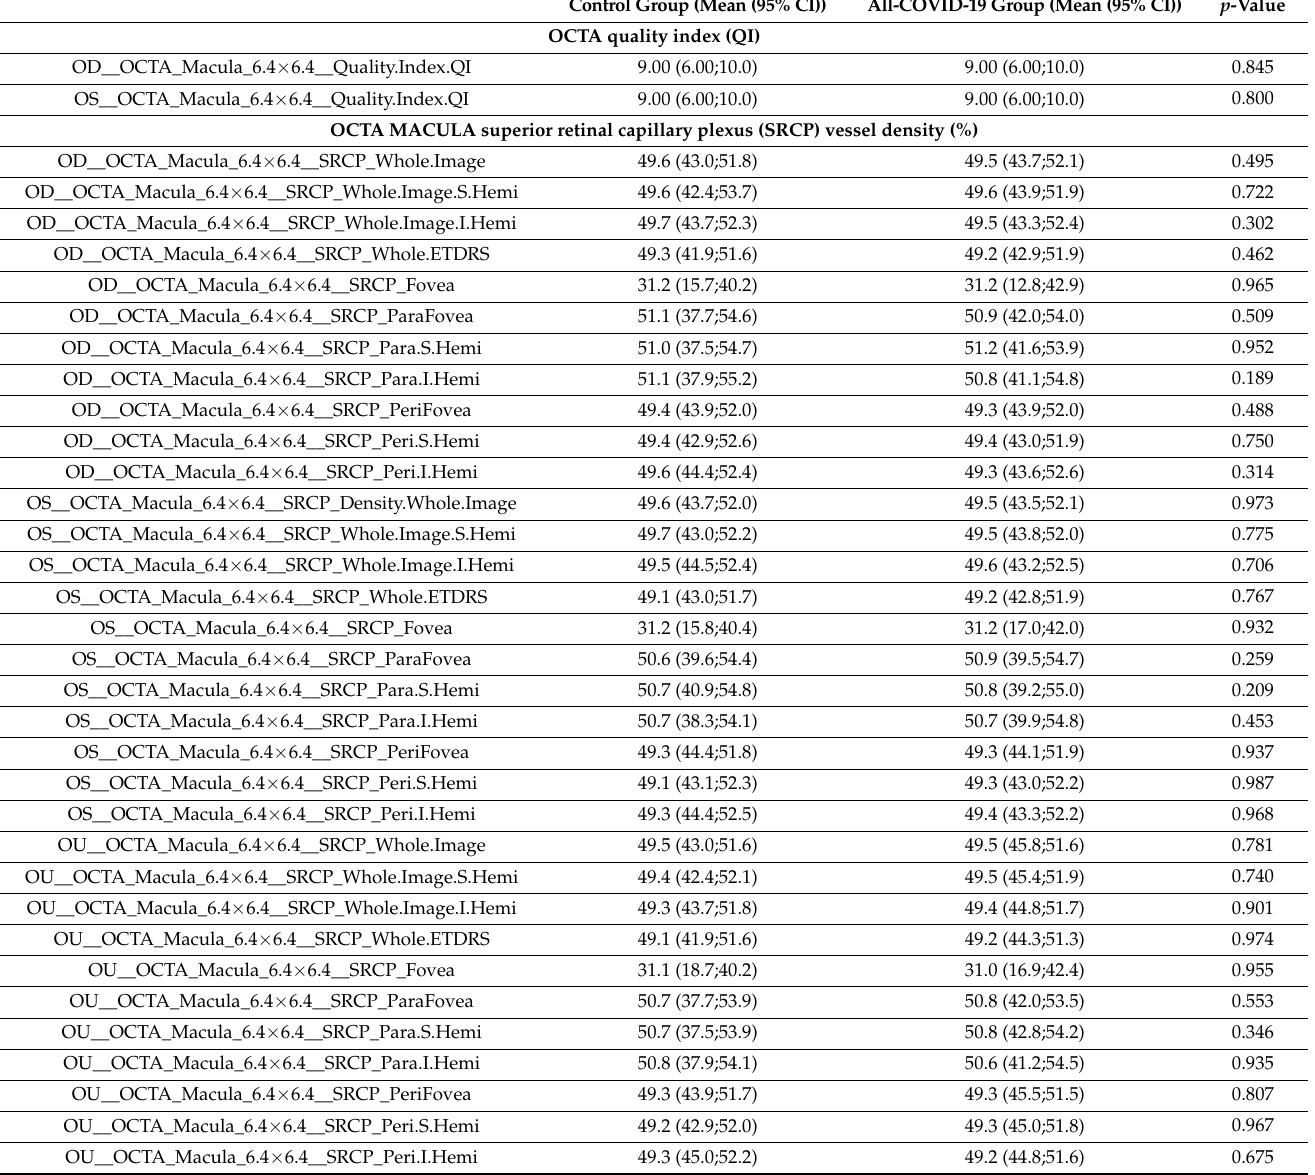
Table 2. Wilcoxon rank sum test